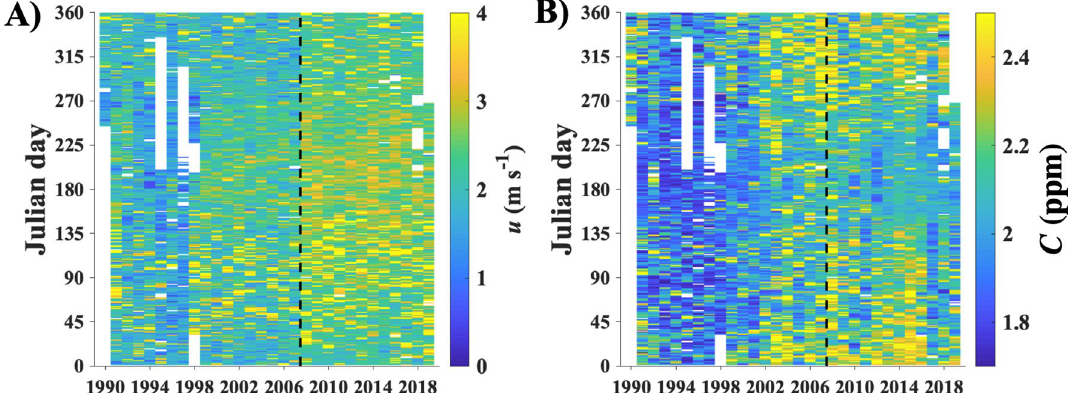
Figure 2. ( A ) 1-day averaged wind speed, u, and ( B ) concentration, C. Data key on panels.